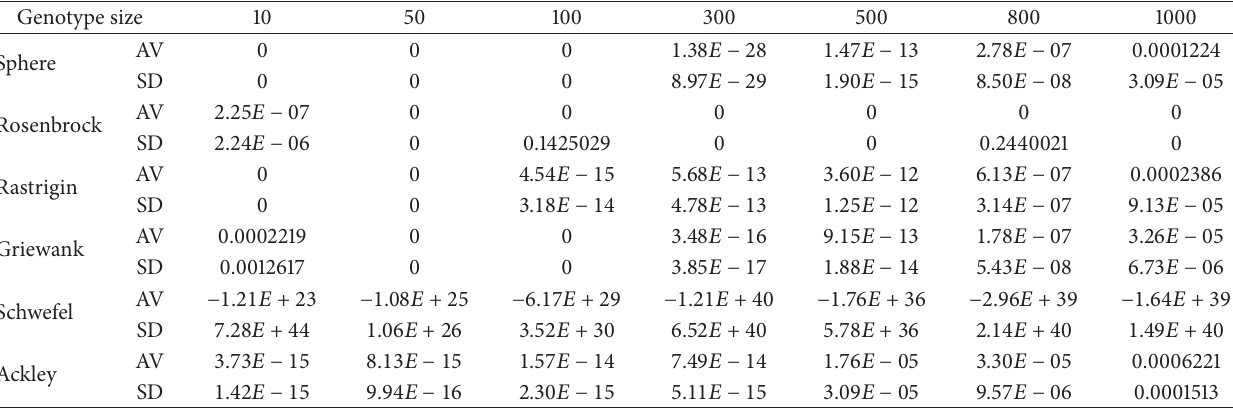
Table 3: Test results of the IMBO algorithm for the genotype sizes of 10, 50, 100, 300, 500, 800, and 1000; number of runs = 30; SD: standard deviation, AV: global minimum average; generation =